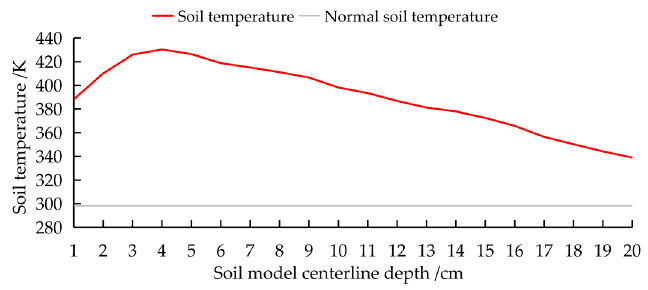
Figure 7. Soil model midline temperature plot.